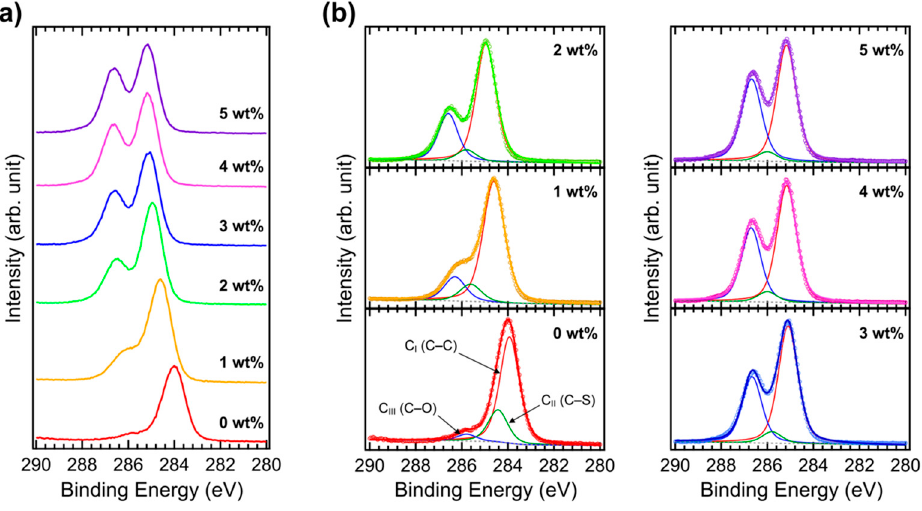
Figure 4. ( a ) XPS O 1s spectra of PEDOT:PSS films with various concentrations of Brij C10 additive (0, 1, 2, 3, 4, and 5 wt%) and ( b ) their fittings.